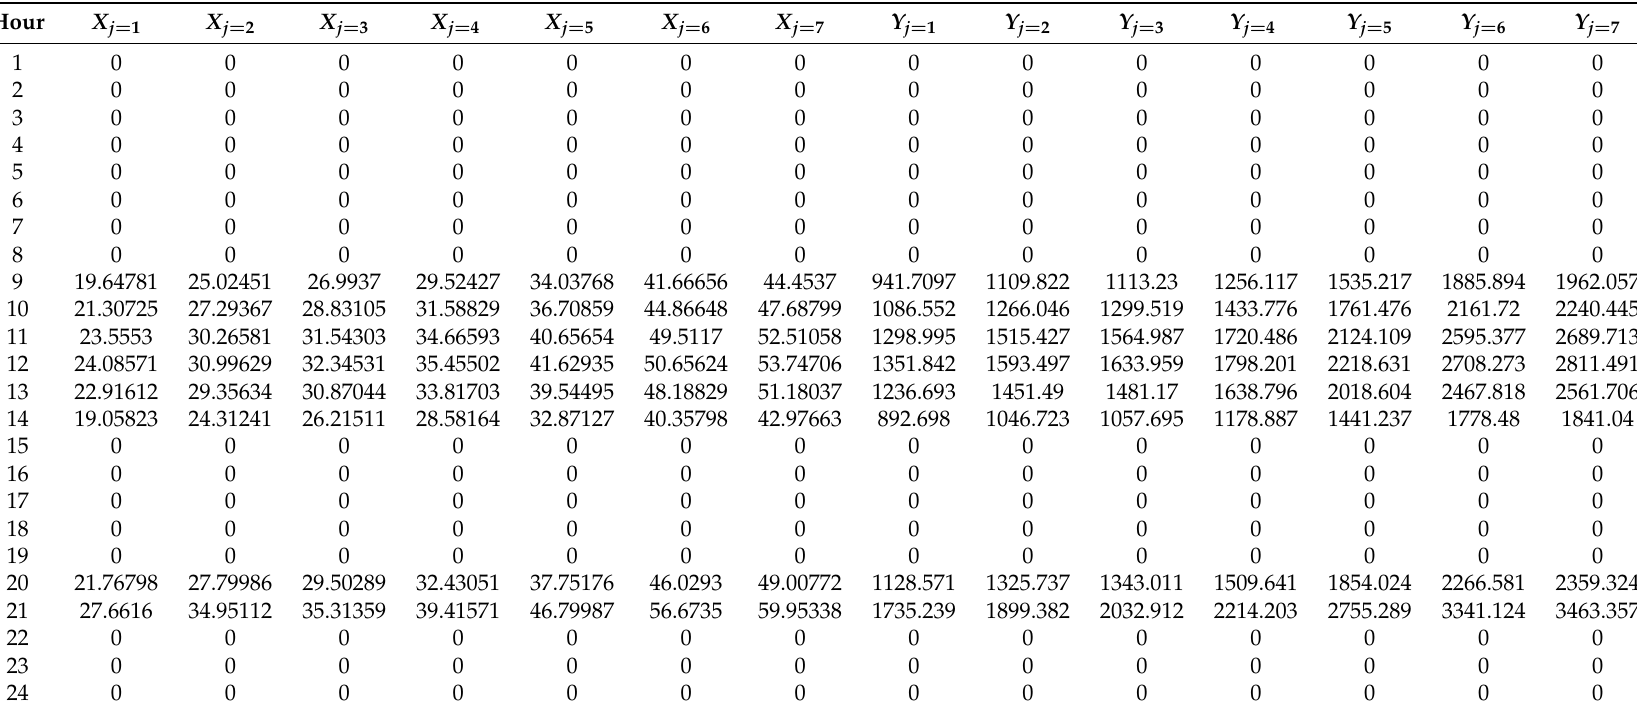
Table A4. Detailed demand response results for Case